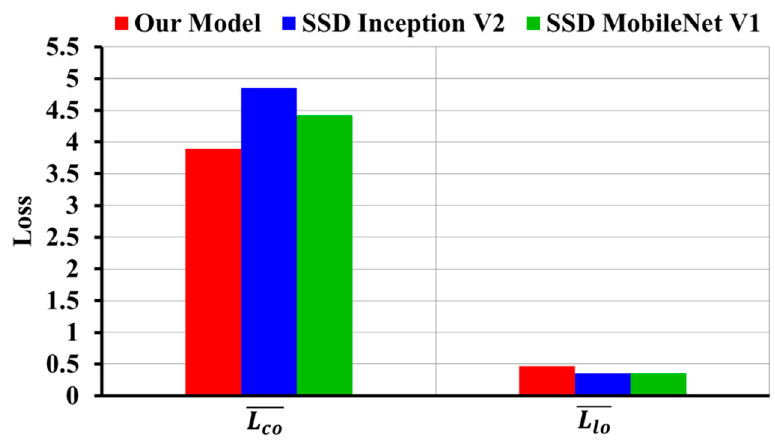
Figure 10. Classification and localization loss comparison on subject-wise testing set.